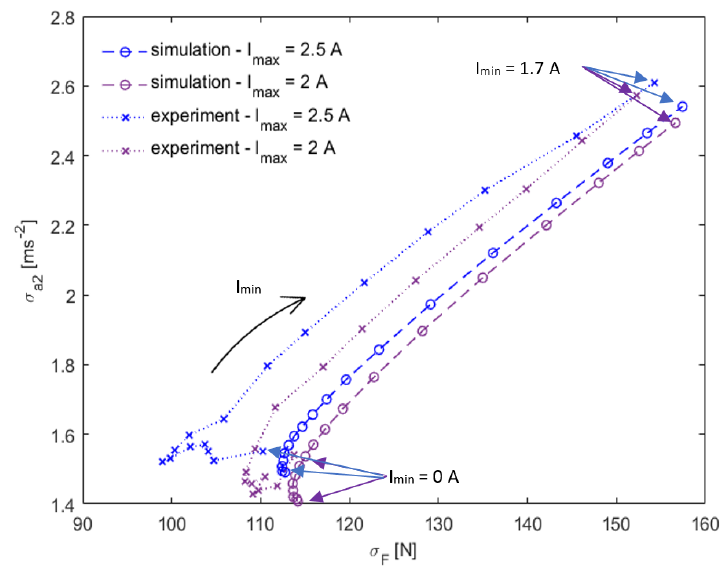
Figure 9. Combined results of the Groundhook algorithms.